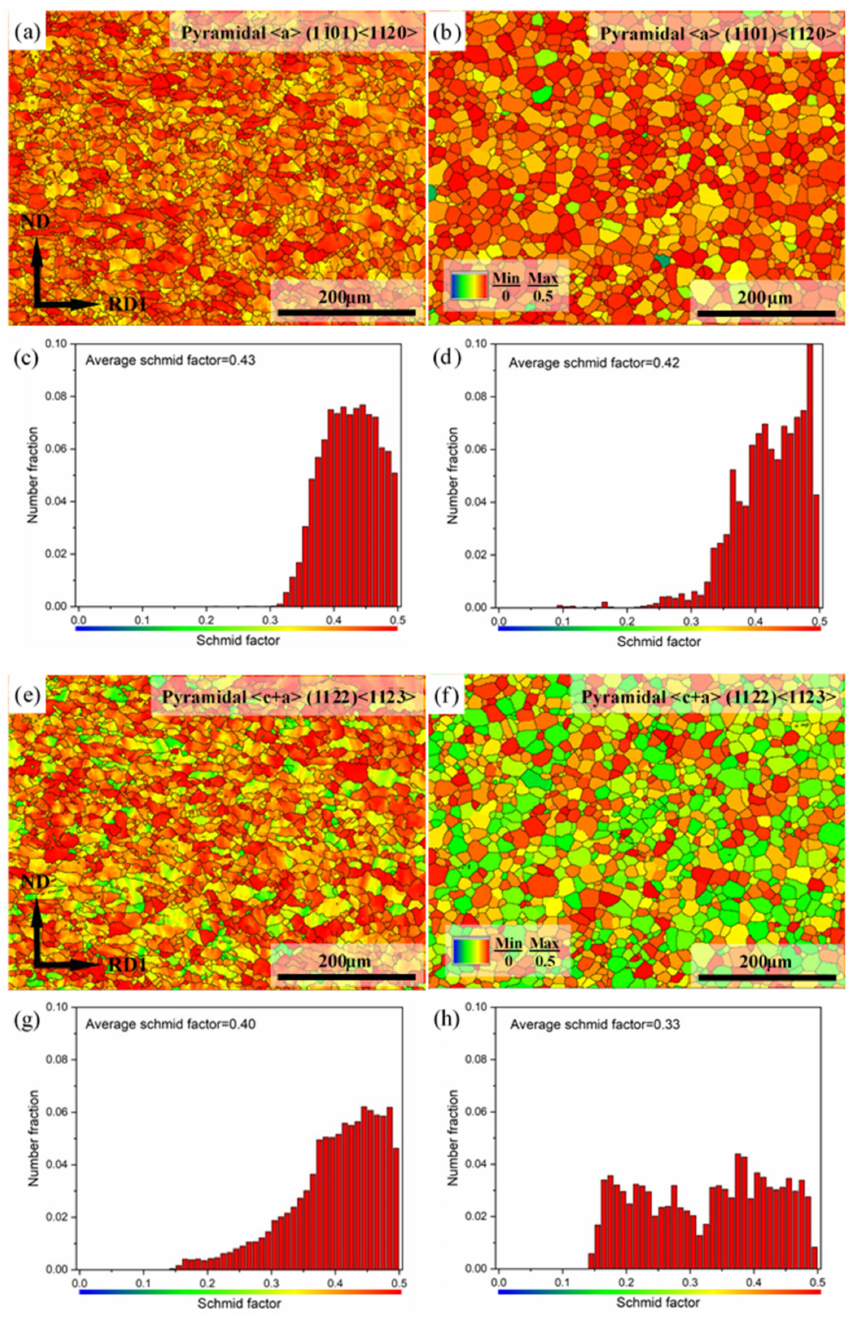
Figure 19. Pyramidal <a> slip SF maps of ( a ) as-rolled, ( b ) as-annealed, and corresponding SF distributions of ( c ) as-rolled and ( d ) as-annealed; pyramidal <c+a> slip SF maps of ( e ) as-rolled, ( f ) as-annealed, and corresponding SF distributions of ( g ) as-rolled and ( h ) as-annealed Mg-3Y sheets. Combined with the analysis of SF above, it can be concluded that the addition of Y into Mg promotes the activity of non-basal slip [52,53]. Both average SF values of prismatic <a> slip, pyramidal <a> slip, and pyramidal <c+a> slip are greater than 0.30 for Mg-3Y-R and Mg-3Y-RA sheets, which show a high activation (Table 2). The